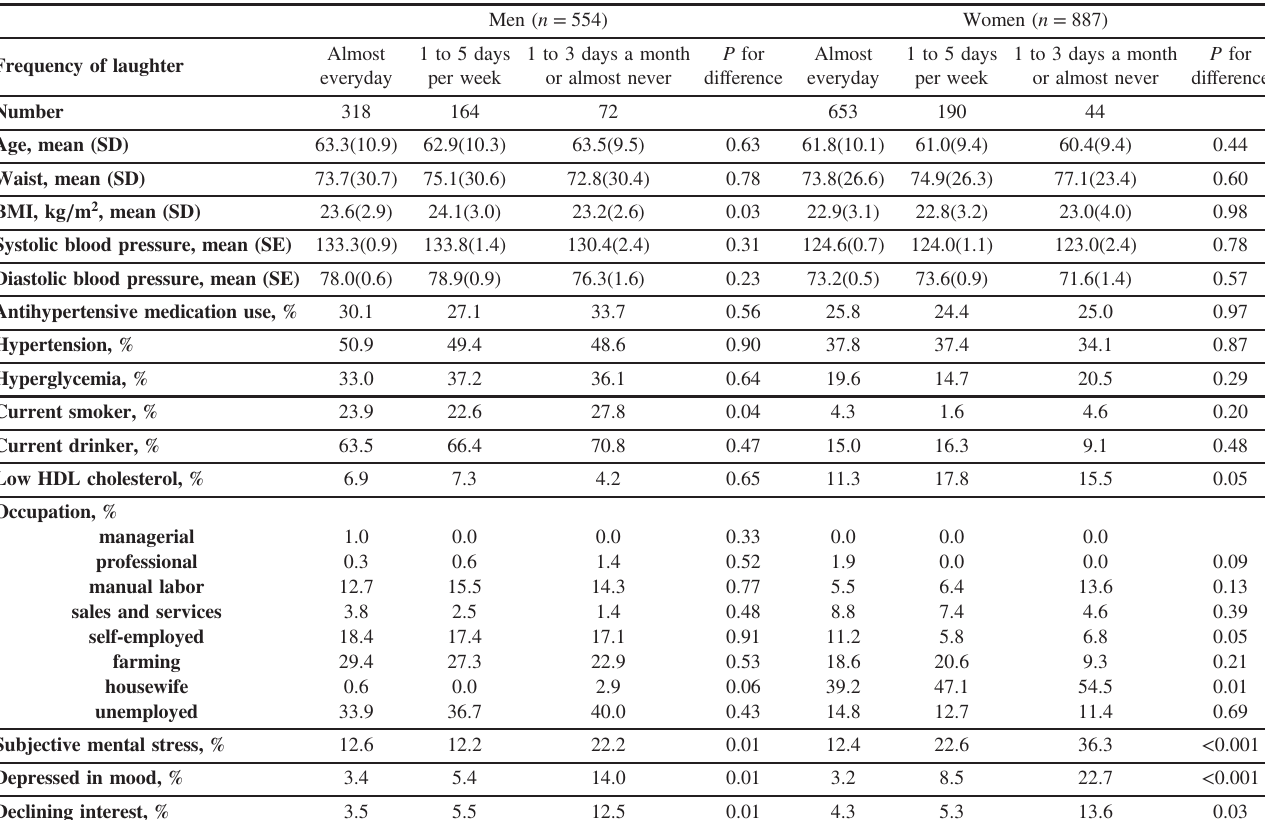
Table 1. Sex-speci fi c baseline characteristics by the frequency of laughter in everyday life ( n = 1,441) Men ( n = 554) Women ( n =